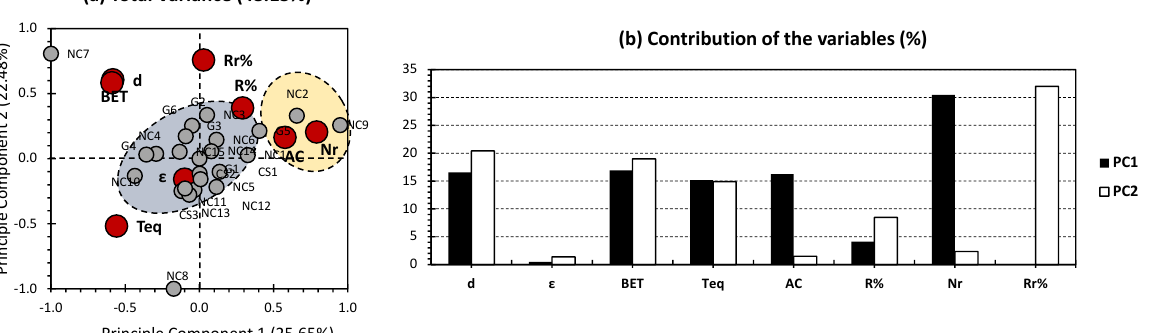
Figure 1. PCA-biplot for all datasets. Grey bullets represent the individuals of the population (different investigated nanocellulose-based aerogels). Red bullets represent the variables (different employed physical/chemical and adsorption parameters). The yellow cluster exclusively gathered NC1 and NC9 while the blue cluster encompasses the rest of the nanocellulose-based aerogels. For the individuals, two different clusters can be distinguished (blue and yellow; Fig- ure 1a). The yellow cluster exclusively gathered NC2 and NC9 and showed a high positive correlation along adsorption capacity and number of reuse/regeneration, which are both part of the investigated adsorption parameters panel (Table 1). Interestingly, NC2 and NC9 showed no or a negative influence according to the physical parameters. In fact, no